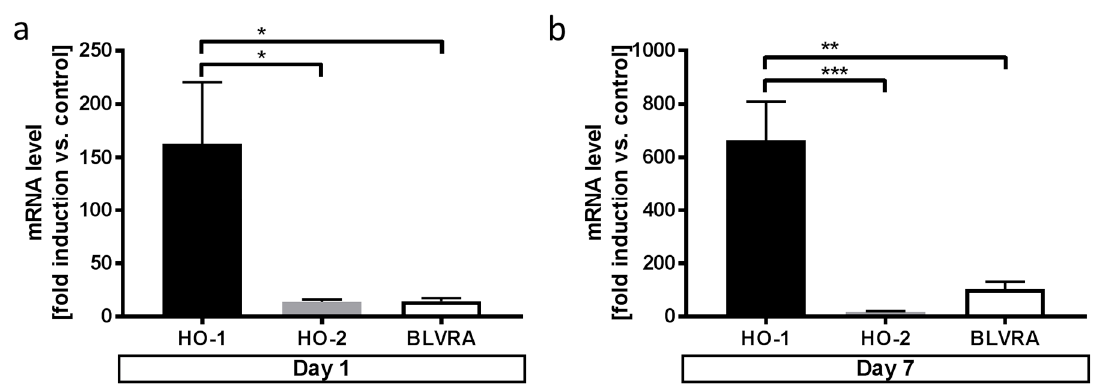
Figure 6. Comparison of HO-1, HO-2, and BLVRA mRNA levels in the cerebrospinal fluid (CSF) after SAH. ( a ) HO-1 vs. HO-2 and BLVRA mRNA level in cells of the CSF in SAH patients on day 1 (following SAH (Student’s t -test; * p = 0.03 HO-1 vs HO-2 and HO-1 vs BLVRA). ( b ) HO-1 vs HO-2 and BLVRA mRNA level in cells of the CSF in SAH patients on day 7 following SAH (Student’s t -test; *** p = 0.0003 HO-1 vs. HO-2; ** p = 0.002 HO-1 vs BLVRA).